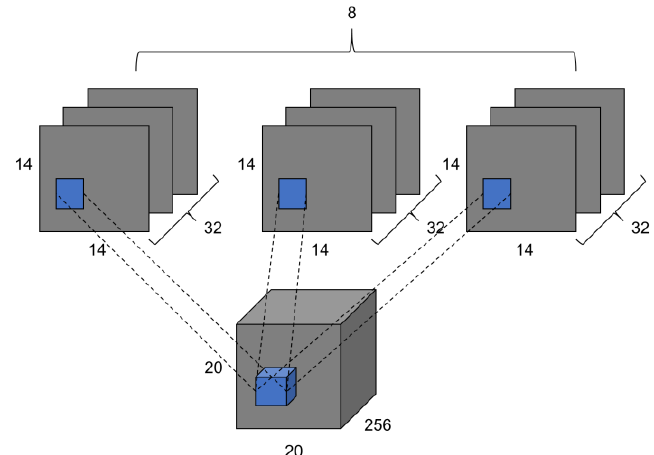
Figure 8. Convolution of Primary Caps.